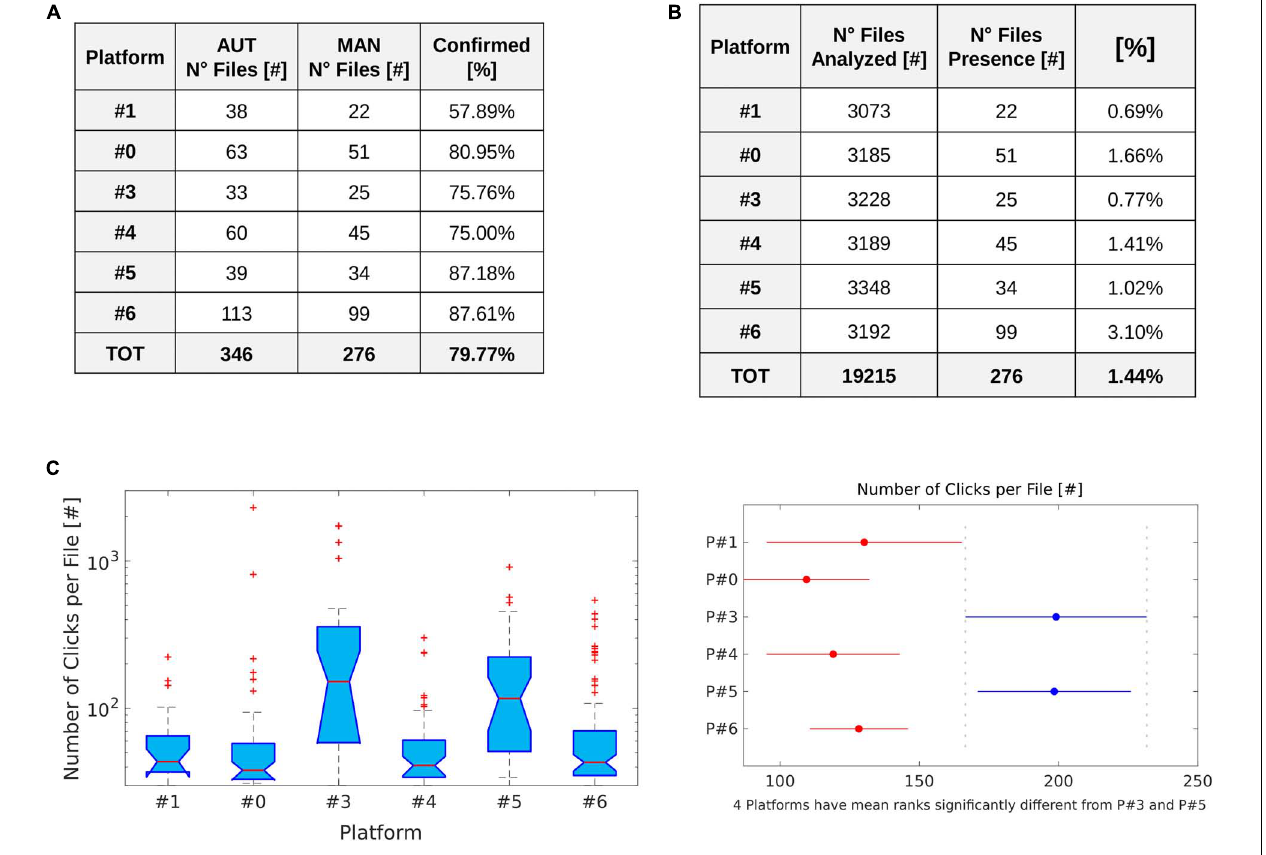
FIGURE 7 | IPHD occurrence. (A) Table showing the results of the checks of automatic detection and classification of IPHD clicks (AUT) through manual analysis (MAN). (B) Table with information about the total number of files acquired by each platform and relative percentage of files with confirmed presence of visible IPHD clicks. (C) Boxplot shows the number of clicks detected per file at the PAM sites (P#1, P#0, P#3, P#4, P#5, P#6). In each box, the central mark indicates the median, and the bottom and top edges of the box indicate the 25th and 75th percentiles, respectively. Whiskers extend to the most extreme data points not considered outliers, and outliers are plotted individually using the “+” symbol (in red). On the right, a multiple pairwise comparison of mean ranks was performed to test significant differences between the PAM